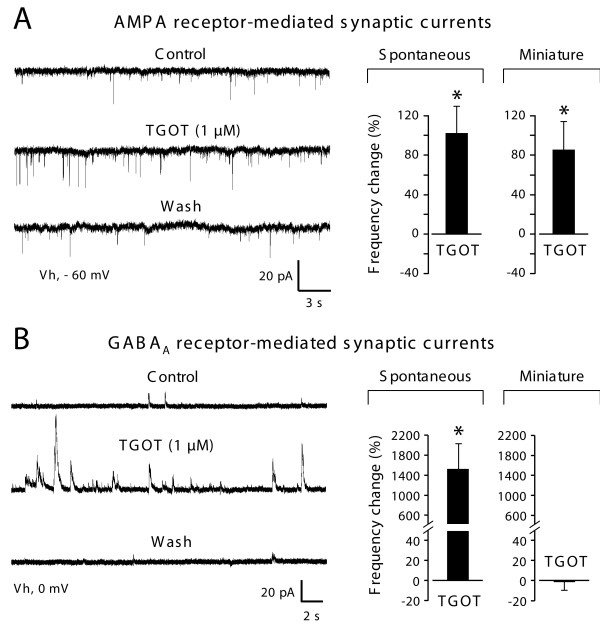
Differential effects of a selective oxytocin receptor (TGOT) on glutamatergic and GABAergic synaptic currents. A: Raw recordings of spontaneous AMPA-R sEPSCs (left traces) illustrate the increase of frequency triggered by the application of TGOT (1 μM). This effect was reversible and observed in 35.7% of the lamina II neurons. Histograms on the right show the mean increase (± SEM) in frequency (with respect to control) of sEPSCs and mEPSCs. B: Elevation in the frequency of occurrence of GABAA-R sIPSCs was observed in all lamina II neurons recorded (n = 6 out of 6; raw traces and histogram on the left). However, TGOT never changed the frequency of miniature GABAA-R events (right histogram). Asterisks indicate statistical significance using Student's t-test, p < 0.05.